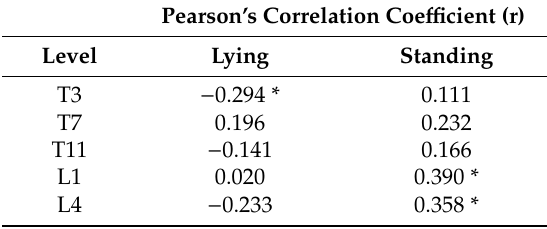
Table 3. Relationship between the SWE and TUPS measurement techniques ( n =